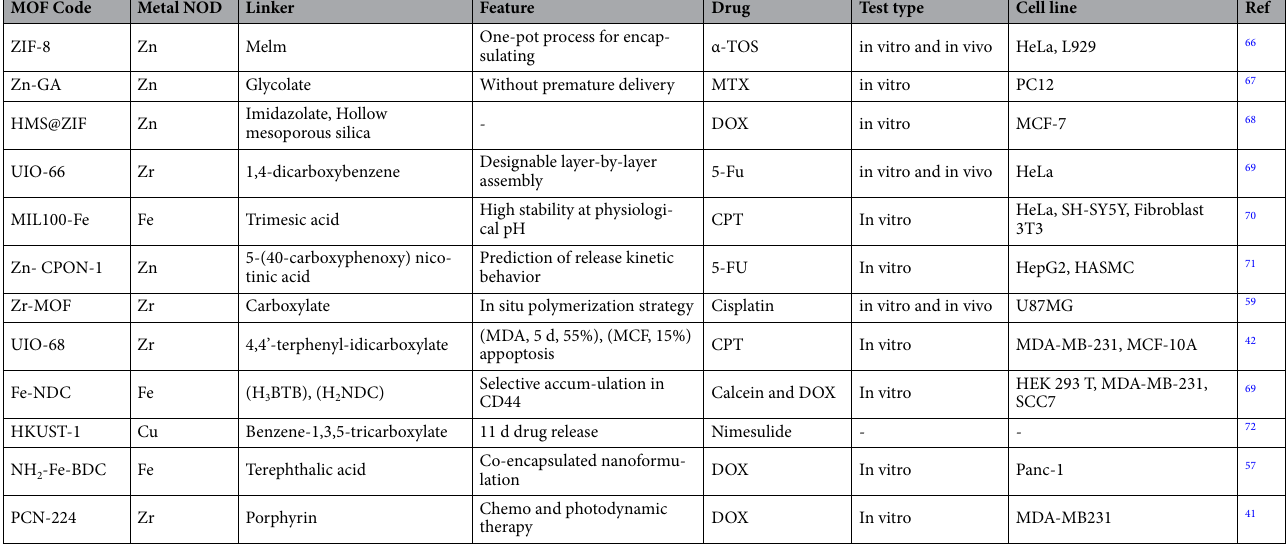
Table 2. Various outstanding metal–organic frameworks and their biomedical